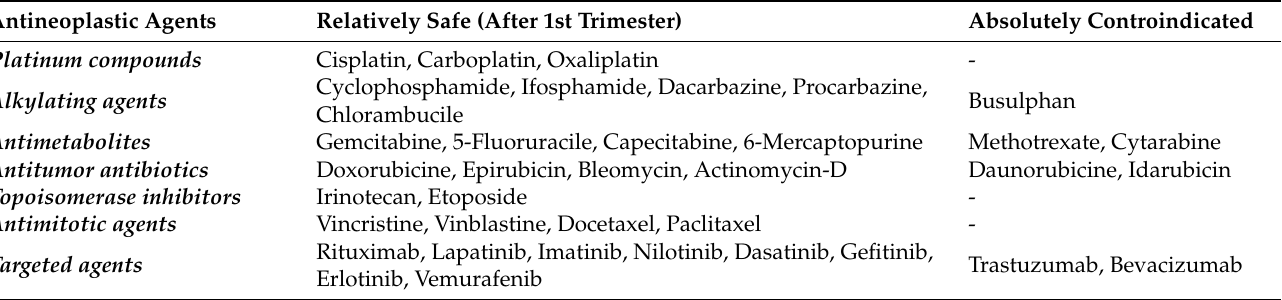
Table 2. Relatively safe and absolutely contraindicated antineoplastic